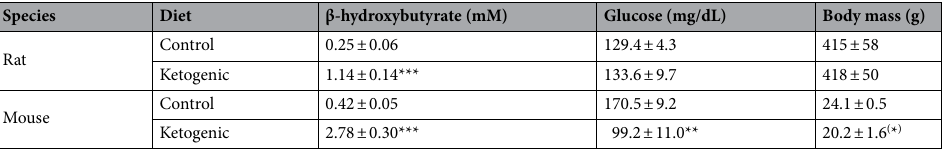
Table 1. Effect of diet treatment on physiological parameters. Physiological measures were taken after the end of behavioral testing. Control v. ketogenic ***p < 0.001, **p < 0.01, ( * ) p = 0.06. Rat: n = 12 CD, 14 KD; mouse: n = 6 CD, 8